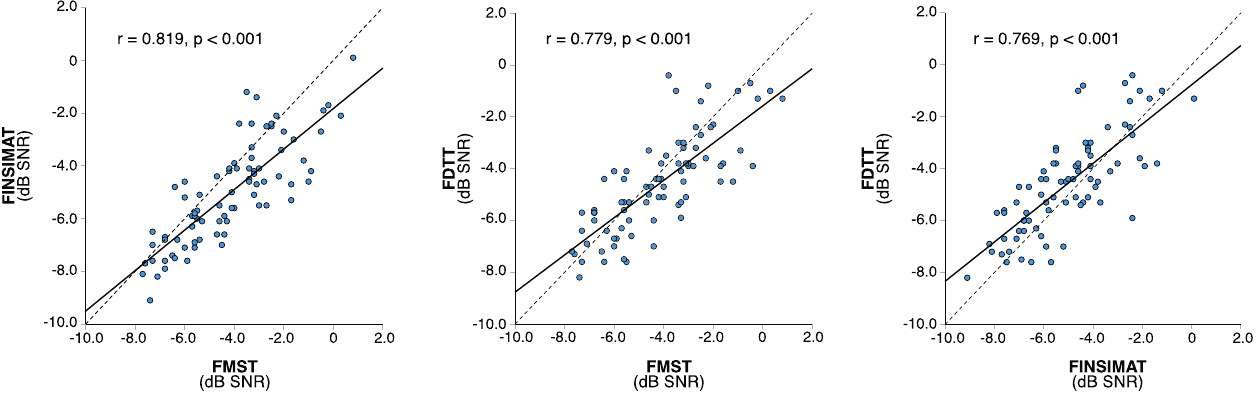
Figure 1. Speech reception threshold (SRT) estimates in dB signal-to-noise ratio (SNR) plotted against each other for the three-speech intelligibility in noise tests with a linear regression plotted as a solid line. Pearson correlation coefficients (r) and p -values are included for all regression plots. FMST, Finnish matrix sentence test; FINSIMAT, Finnish simplified matrix sentence test; FDTT, Finnish digit triplet test.